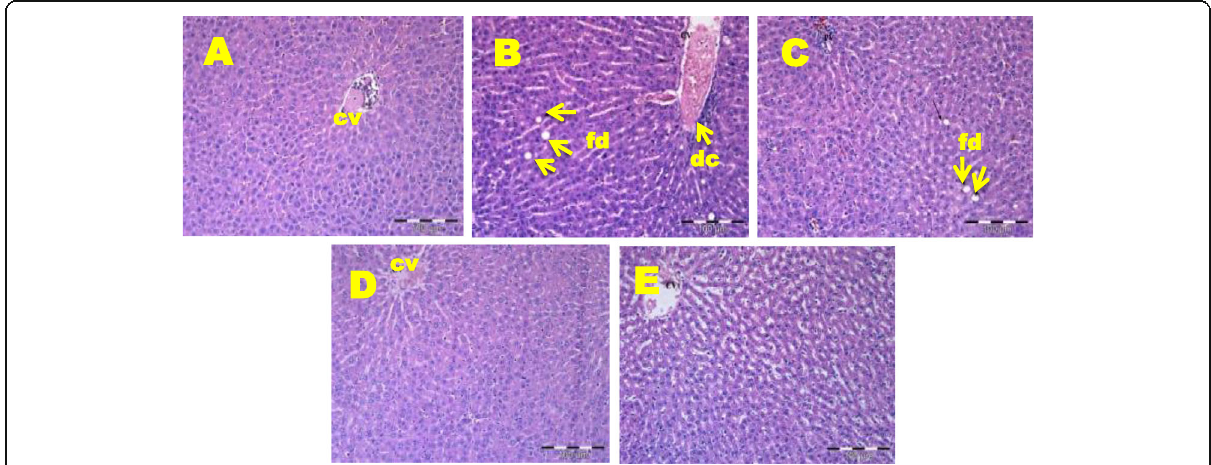
Fig. 1 Histopathology of liver in NC, OC and GMF supplemented rats. Haematoxylin and eosin staining of liver tissues showing enlarged hepatocytes and fat droplets (marked as “ fd ” ) (× 20), and dilated central vein (marked as “ dc ” ) (× 20). CV, central vein; a , normal control (NC); b , obese control (OC); c , 200 mg G. mangostana flesh / kg body weight (GMF 200); d , 400 G. mangostana flesh / kg body weight (GMF 400); e , 600 G. mangostana flesh / kg body weight (GMF